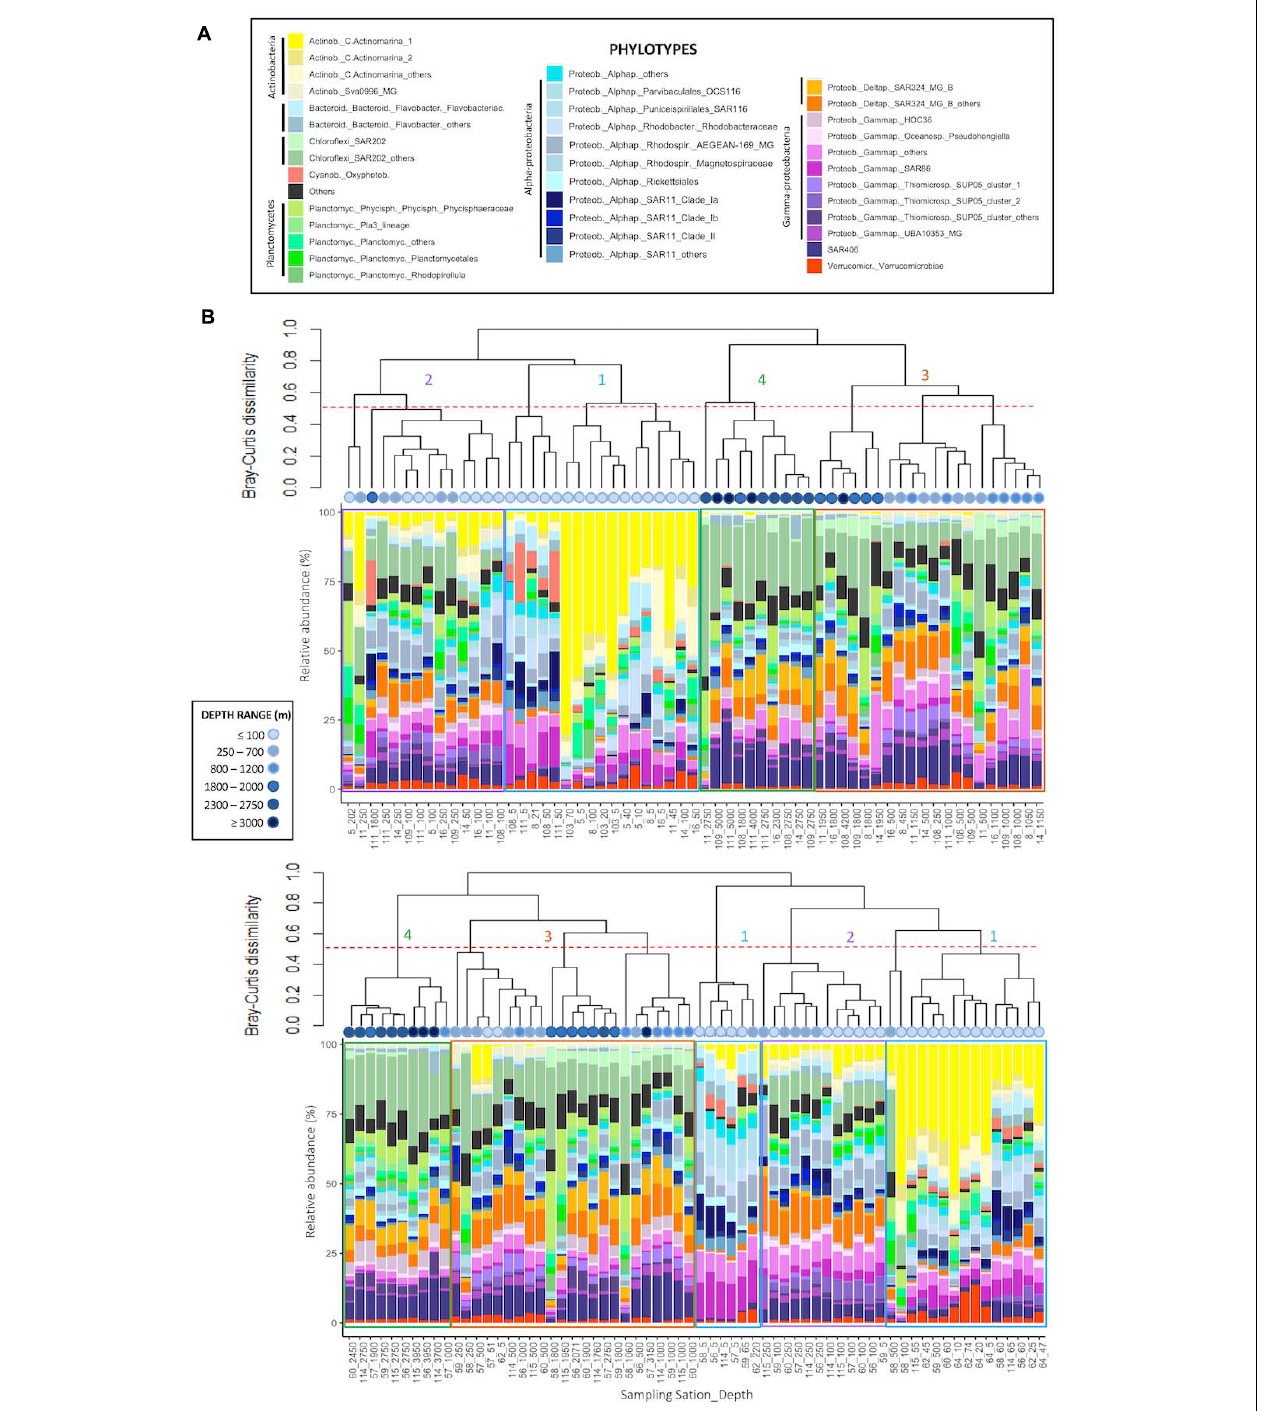
FIGURE 4 | Cluster dendrogram based on Bray-Curtis dissimilarity (after Hellinger transformation) among samples, associated to the plot of community composition in terms of the relative abundance (%) of abundant (with relative abundance higher than 1% of total number of sequences in the dataset) Bacteria phylotypes per sample: (A) Fisterra, and (B) Santander sections. Red-dashed line shows 50% of dissimilarity. Boxes help to visualize the 4 different clusters: cluster 1 = upper subsurface (depth ≤ 100 m, blue); cluster 2 = lower subsurface (100-500 m, purple); cluster 3 = intermediate (500-2000 m, orange); cluster 4 = deep communities ( ≥ 2000 m, green). See Table 3 for further details on the taxonomy of abundant bacterial phylotypes. For comparative purposes, the same analysis, but constructed under the classical equal-taxonomic-level grouping approach, is shown in Supplementary Figure 10 .